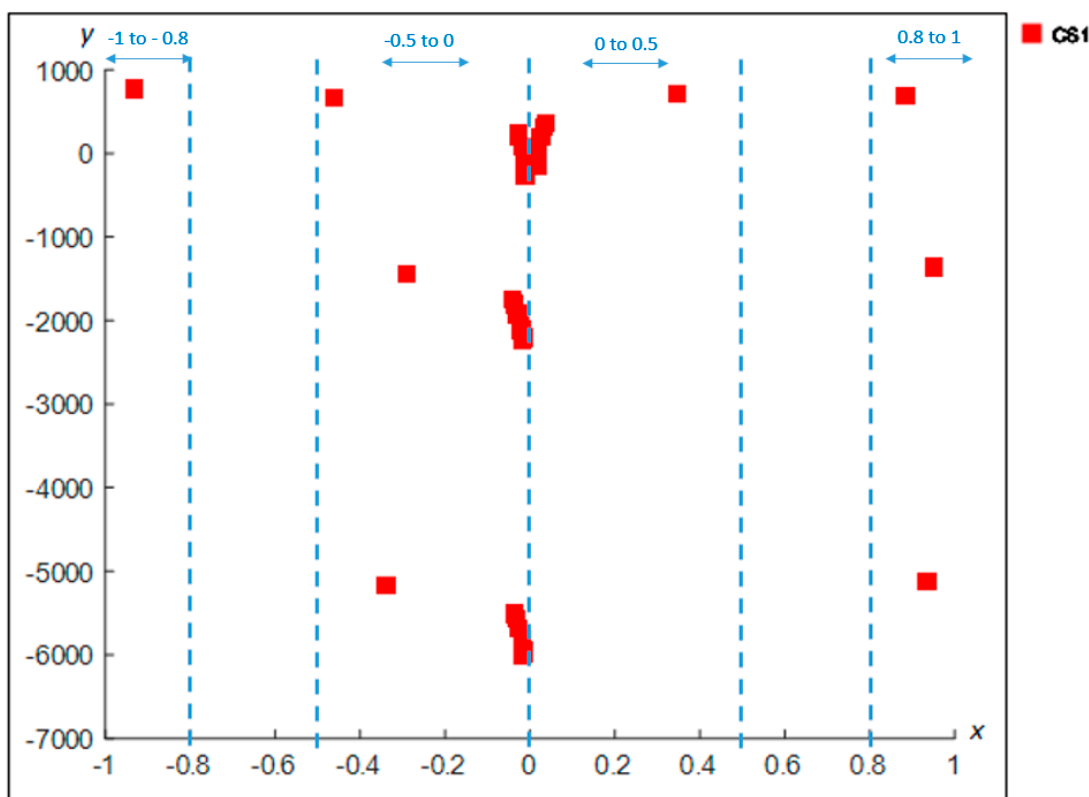
Figure 6. Coordinated FACS of RM100 banknotes of counterfeit sample 1 (CS1).